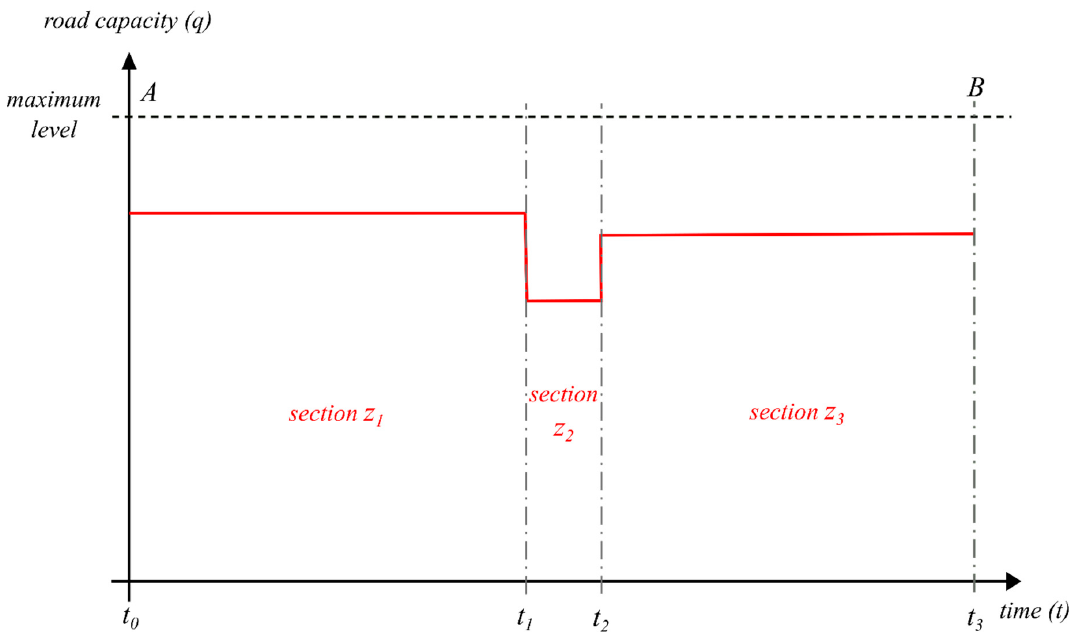
Figure 9. Road capacity and time dependency.